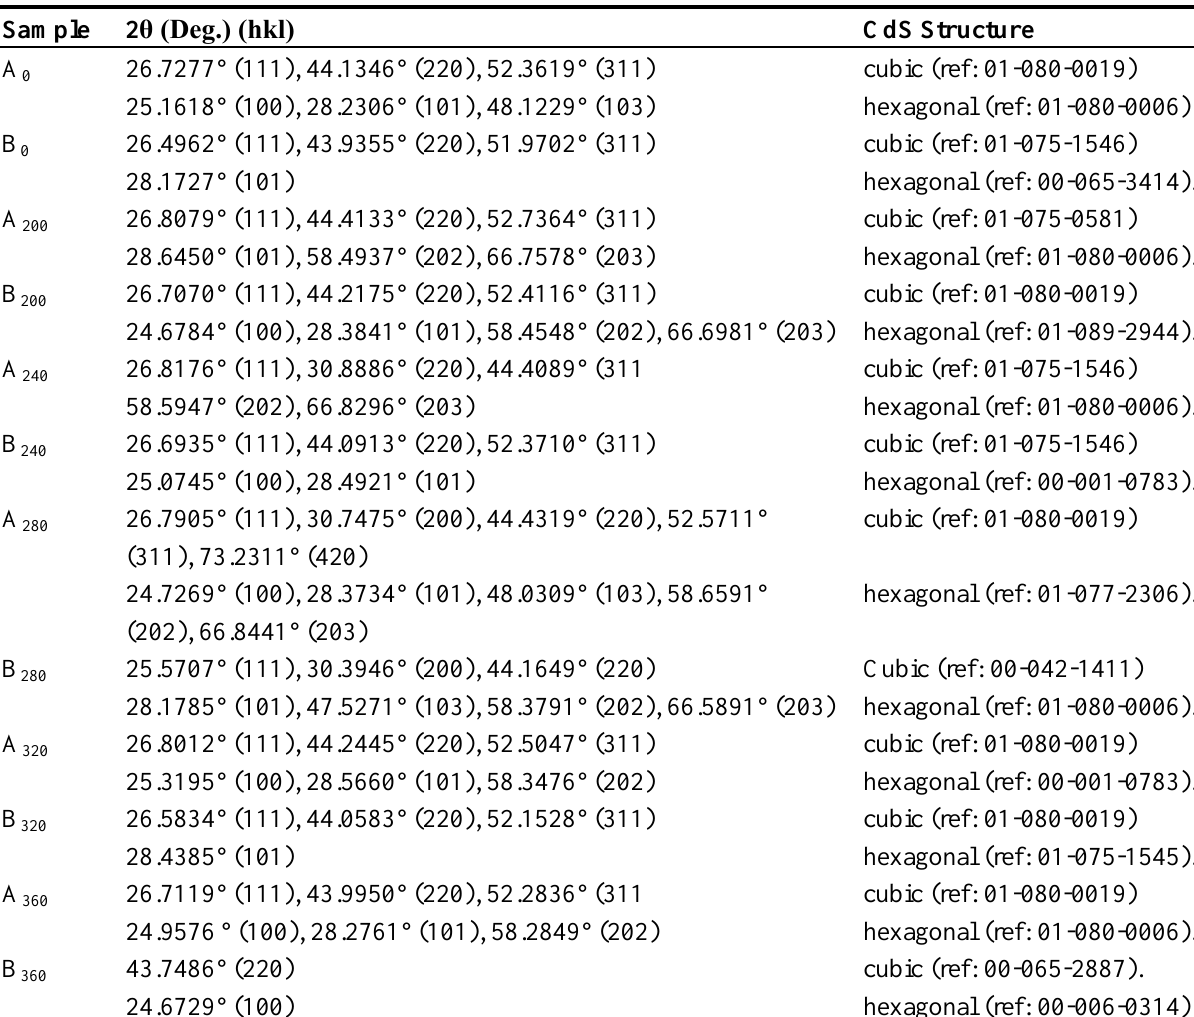
Table 1. A summary of XRD data for all